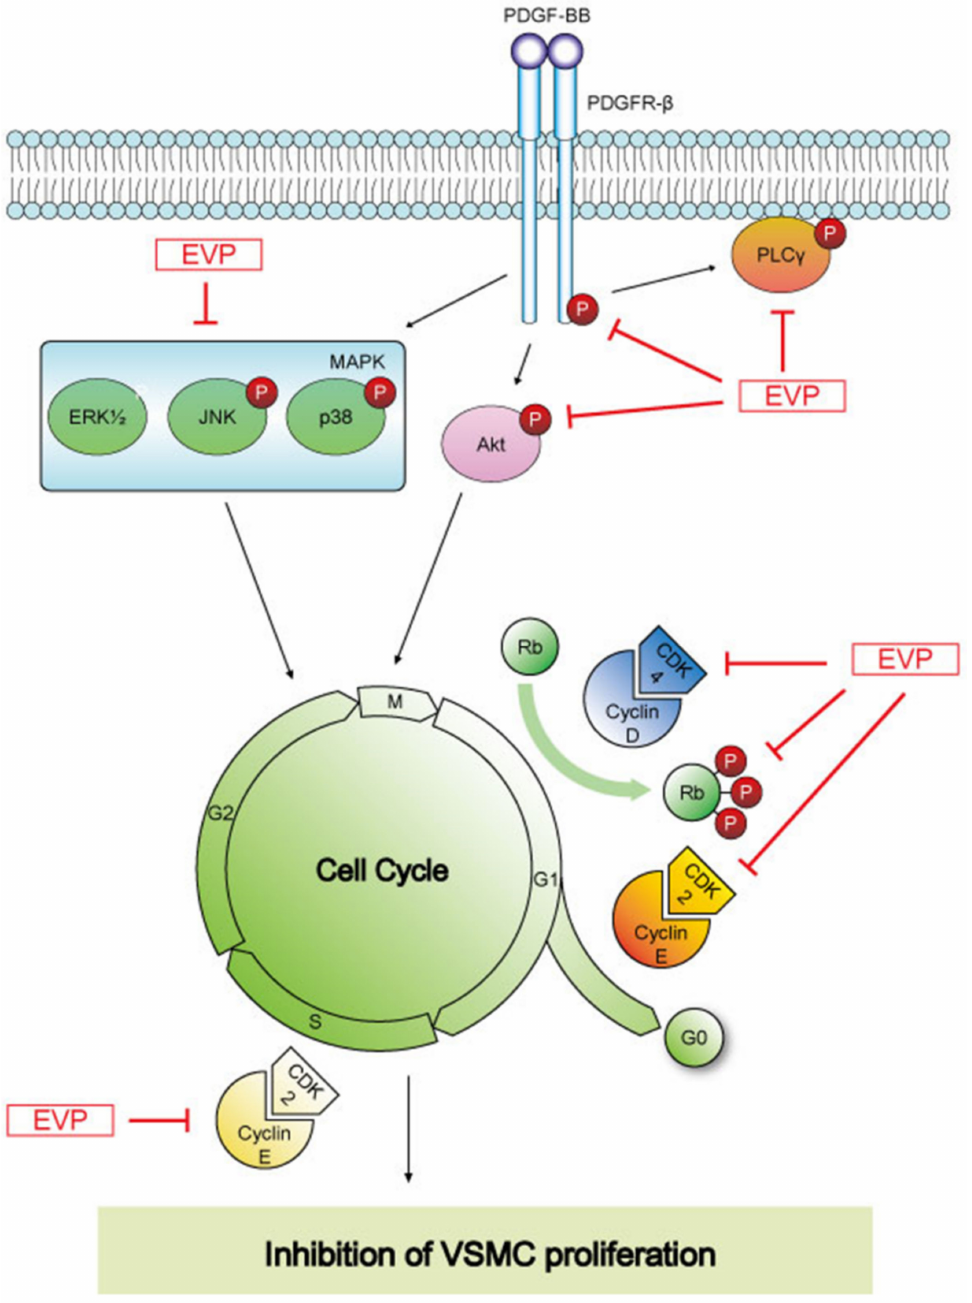
Figure 6. Schematic diagram of the effects of EVP on cell cycle regulatory proteins and PDGFR signaling pathway of